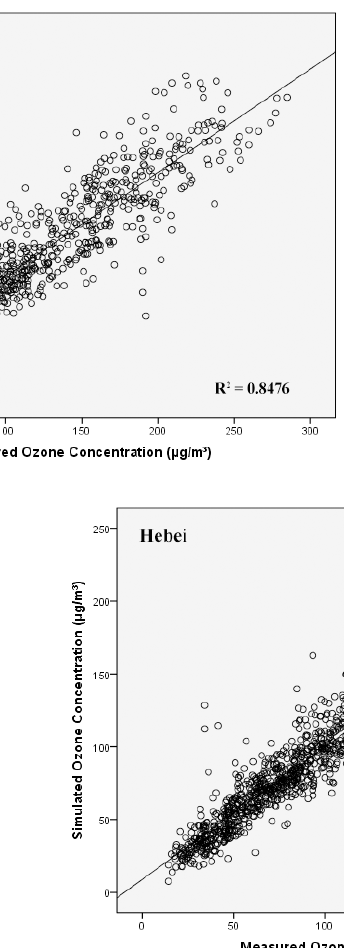
Figure 7. Relationship between the monitored and simulated concentrations of O 3 _8h based on artificial neural network model.